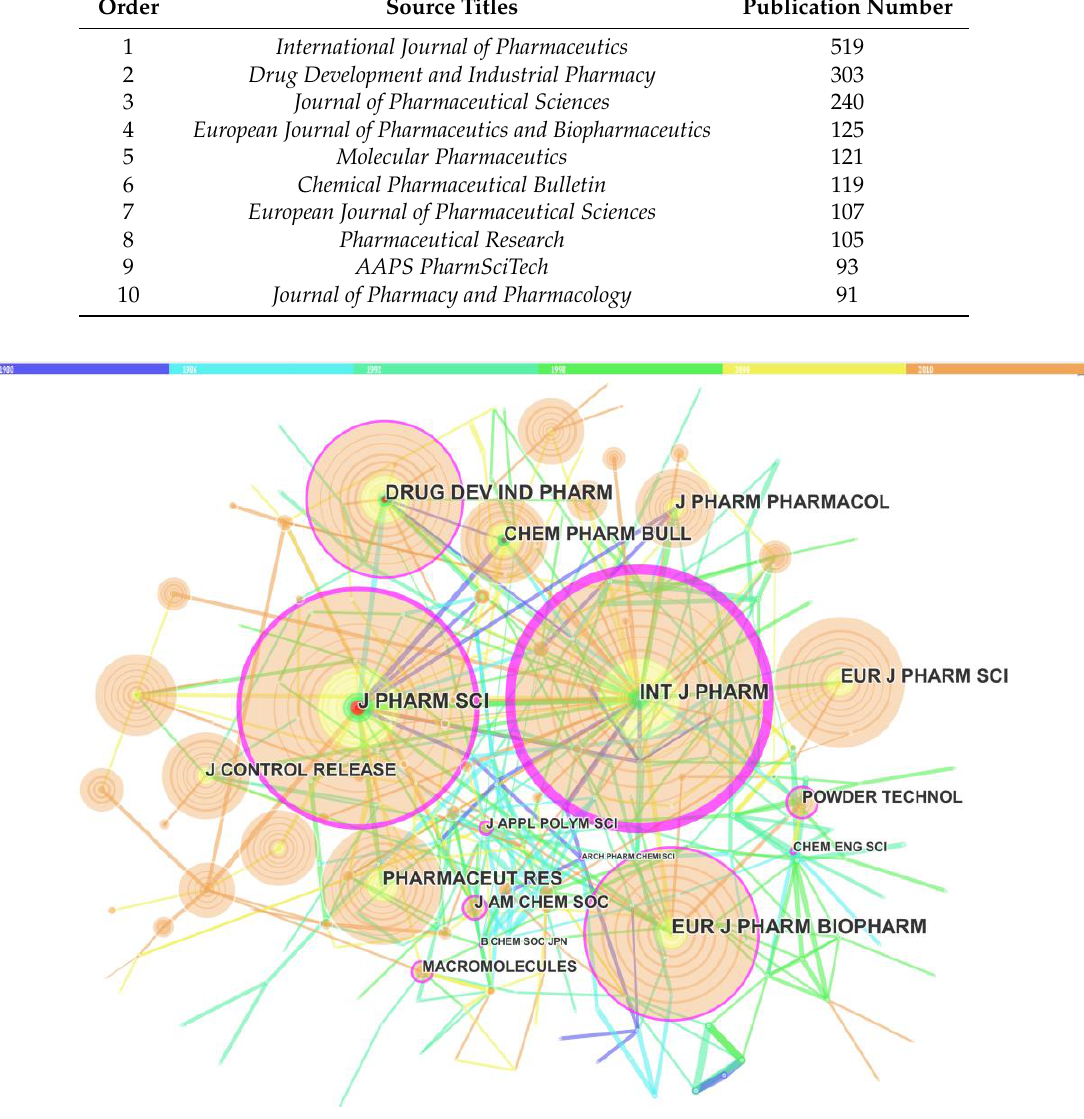
Figure 8. Map of the journal co-citation network. Different colors represent different time slices, deep blue: 1980 to1985, sky blue: 1986 to 1991, pink green: 1992 to 1997, green: 1998 to 2003, yellow: 2004 to 2009 and orange: 2010 to 2015. Each circle represents for one journal. The size of circles was proportional to the citation number. The purple ring of the circles indicates the core journals.